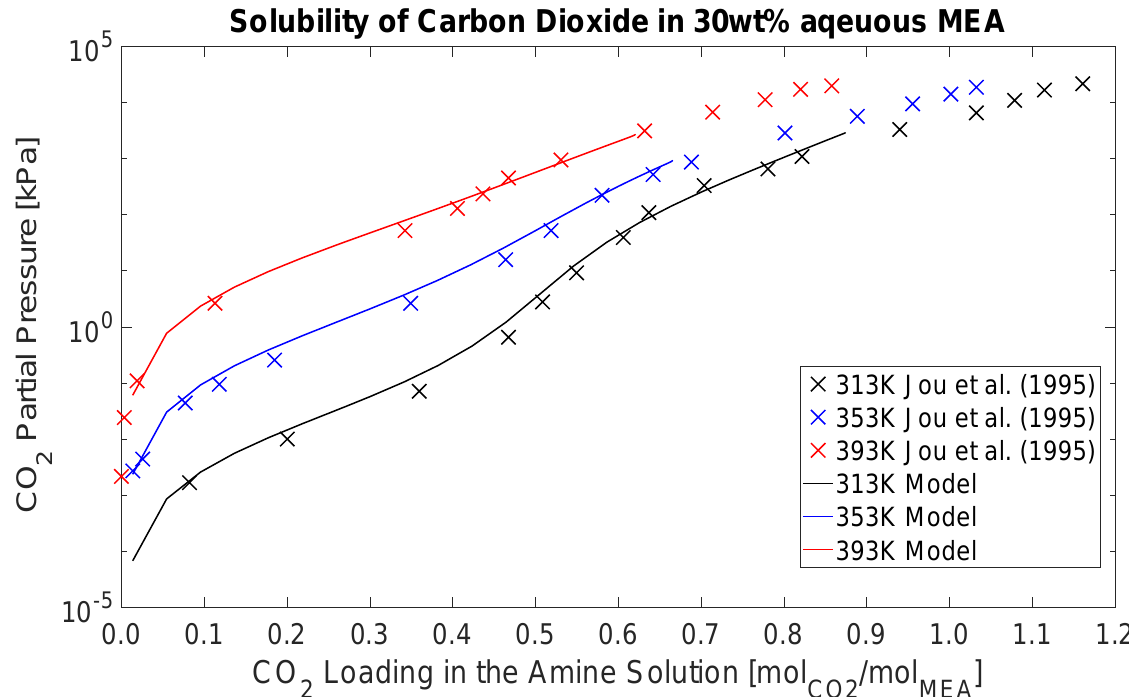
Figure 3. Carbon dioxide loading in 30wt% MEA water solution at different partial pressures and temperatures. Comparison of values predicted by the developed model and experimental data from [34]. Reproduced with permission from Penteado, Ph.D. Thesis, TUB, 2021